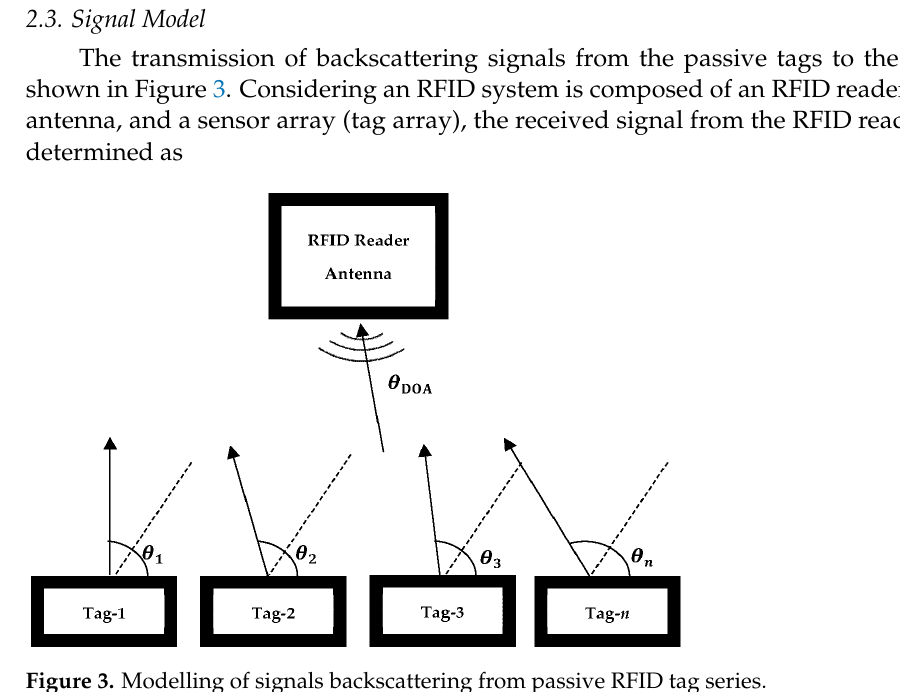
Figure 3. Modelling of signals backscattering from passive RFID tag series.